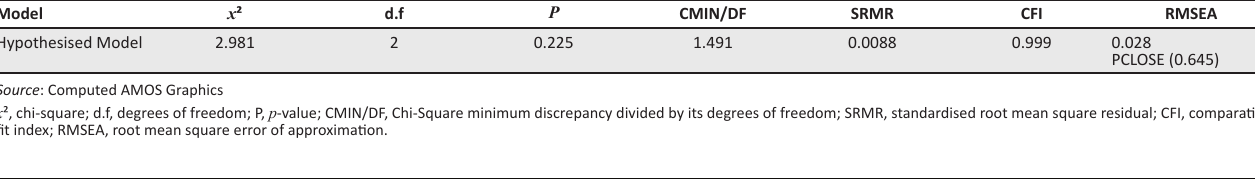
Regression Weights: (Group number 1 - Default model) Standardised Regression